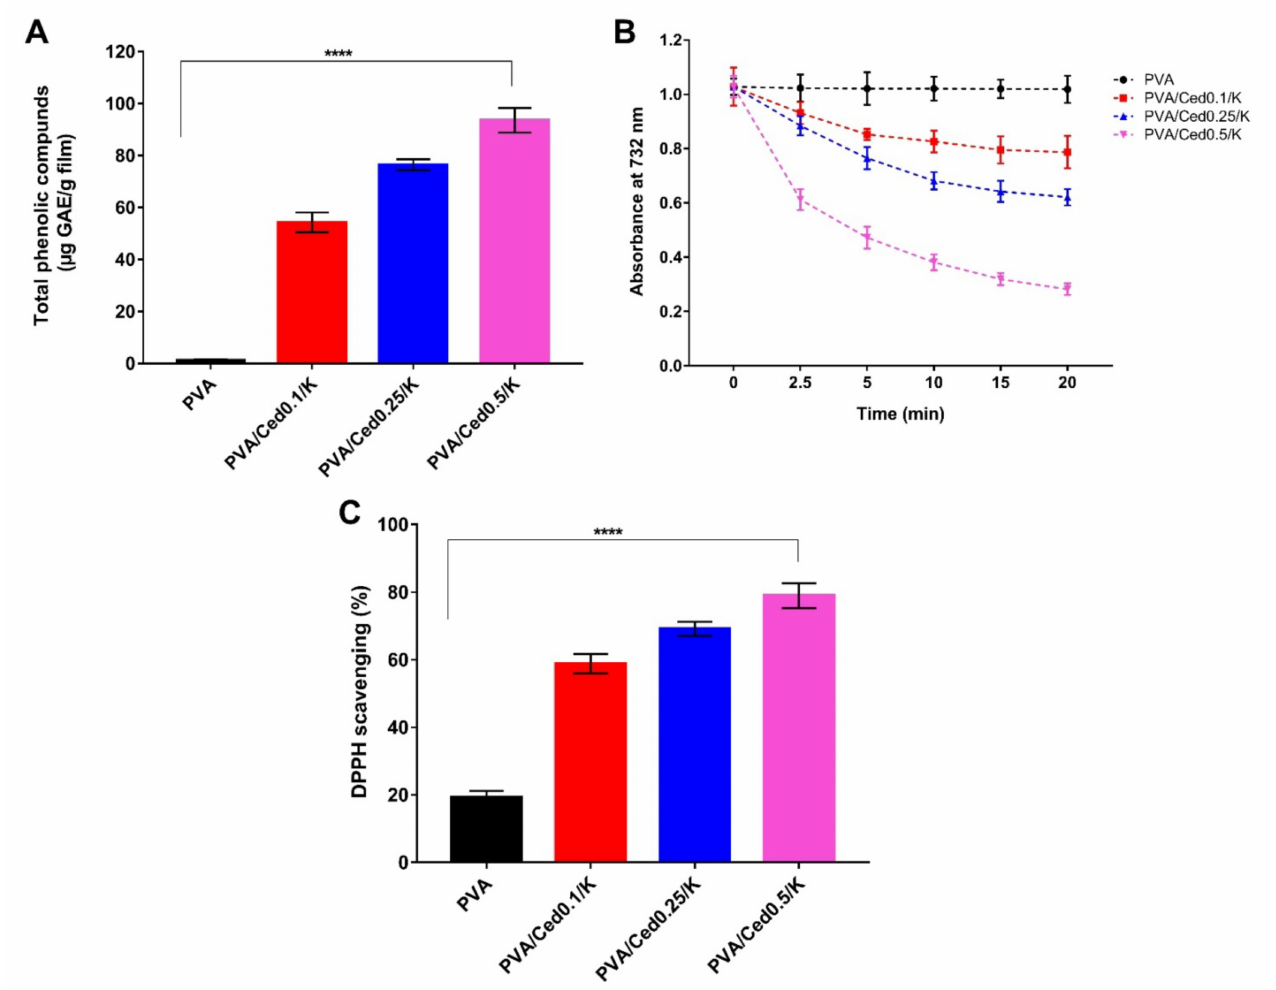
Figure 9. ( A ) Total phenolic compounds released from PVA/Ced/K sponges, ( B ) time-dependent de- colourization of ABTS • + dye by PVA/Ced/K sponges, and ( C ) Scavenging properties of PVA/Ced/K sponges against DPPH free radicals. Results are shown as mean ± SD (**** p <